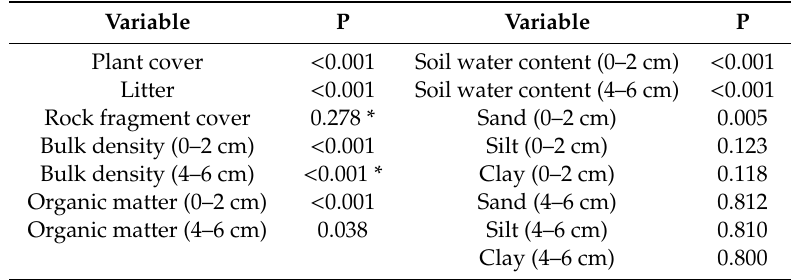
Table 1. Statistical significance (P) among plot characteristics and soil properties di ff erences. Variable